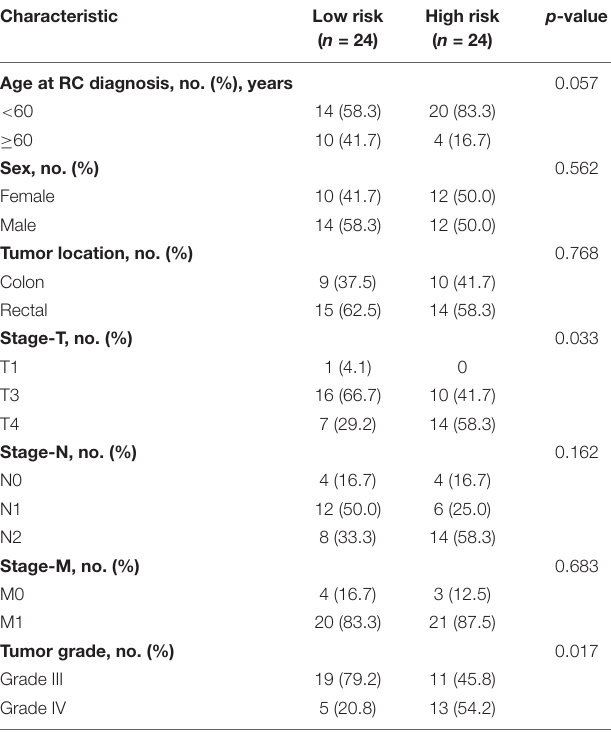
TABLE 2 | Comparisons of baseline characteristics of CRC patients in low- or high-risk group by risk scores.